Question: Give a one-sentence summary of this figure.
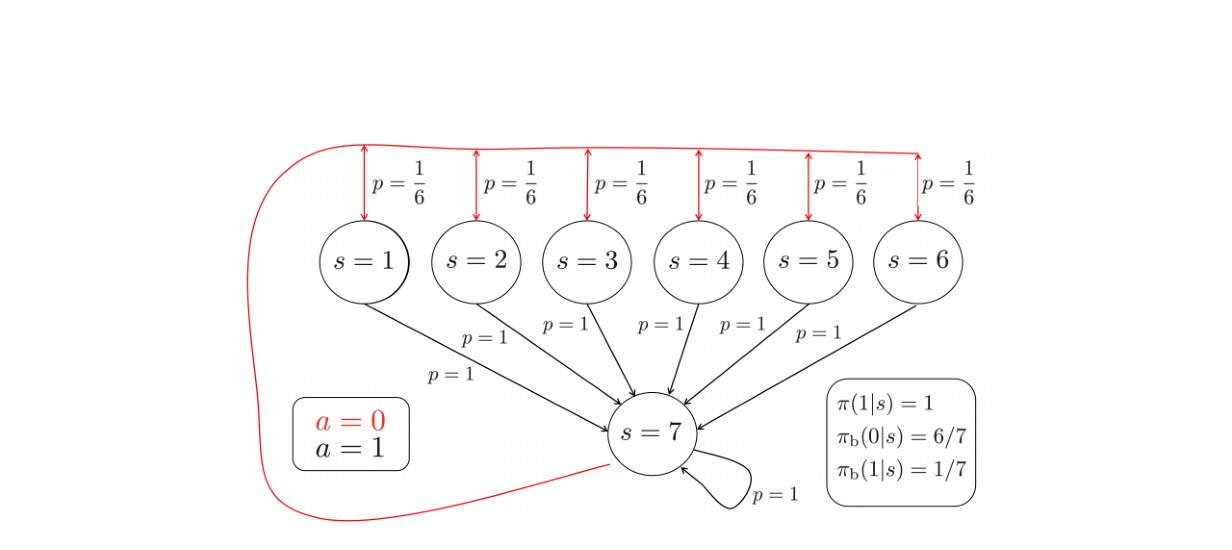
Answer: Baird’s counterexample. Taking action a = 1 always leads to state s = 7, while taking a = 0 leads to one of the other six states with equal probability. The reward is set to be always zero.